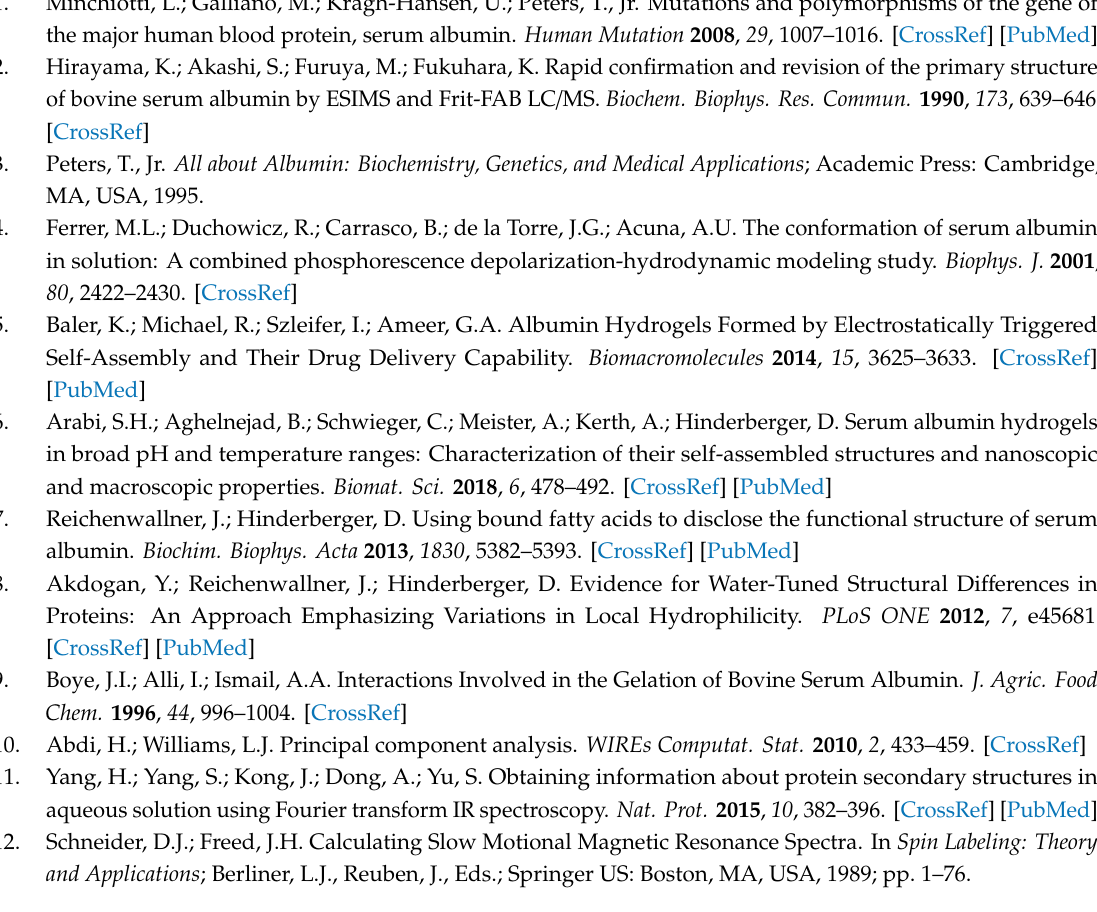
Sample Availability: Samples of the compounds showed in phase diagram (Figure 1) are available from the